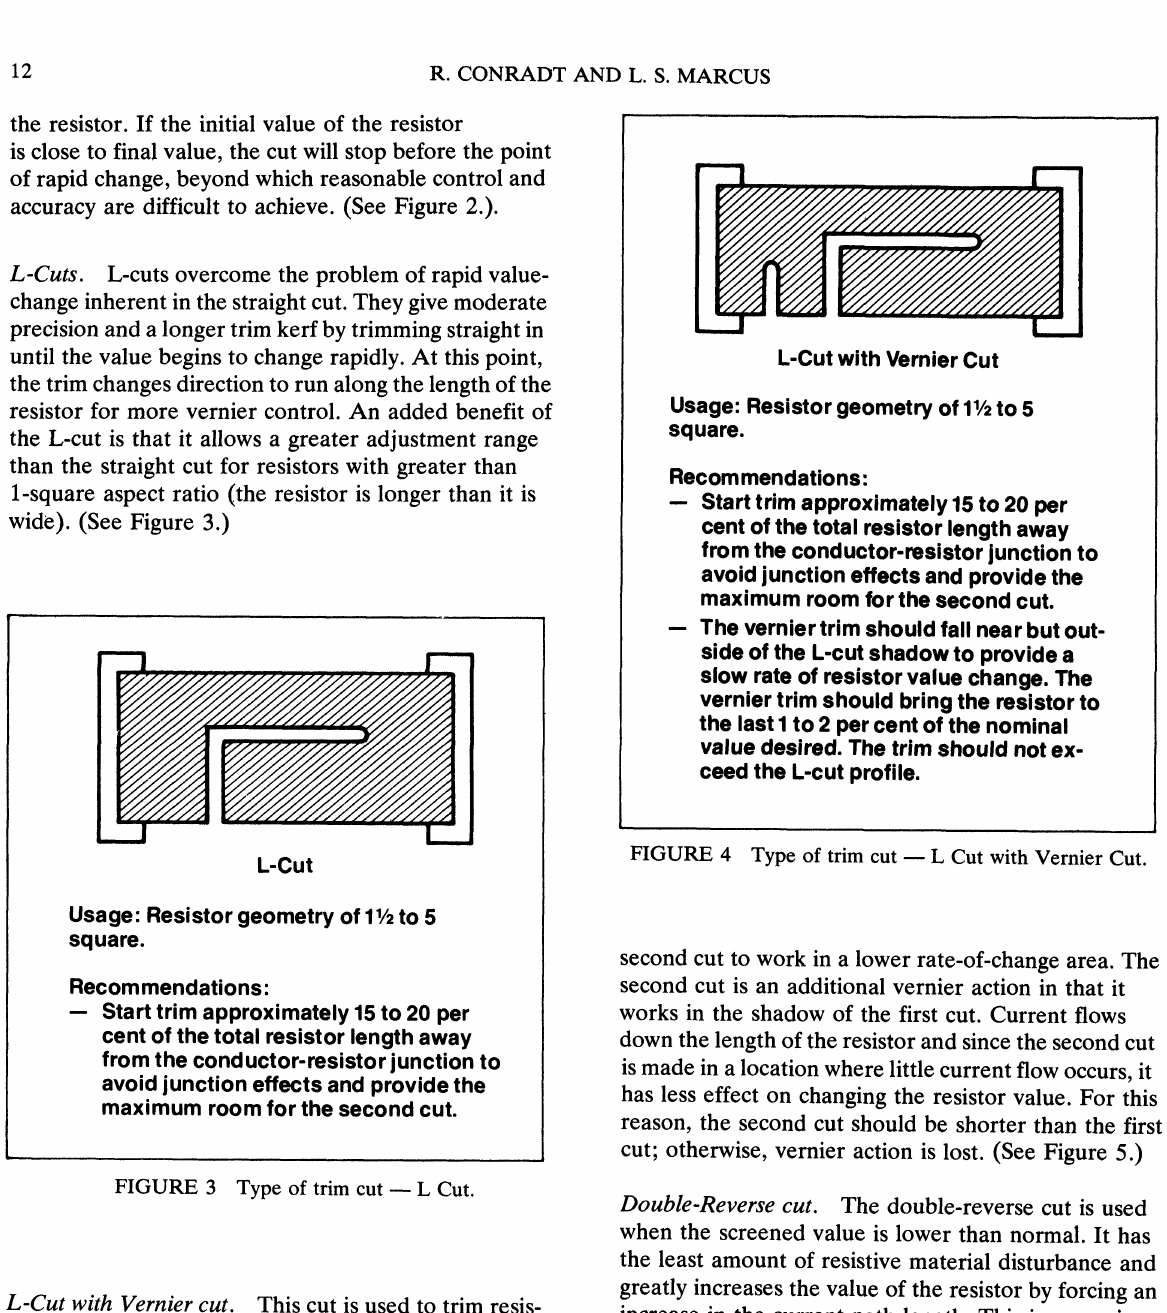
FIGURE 3 Type of trim